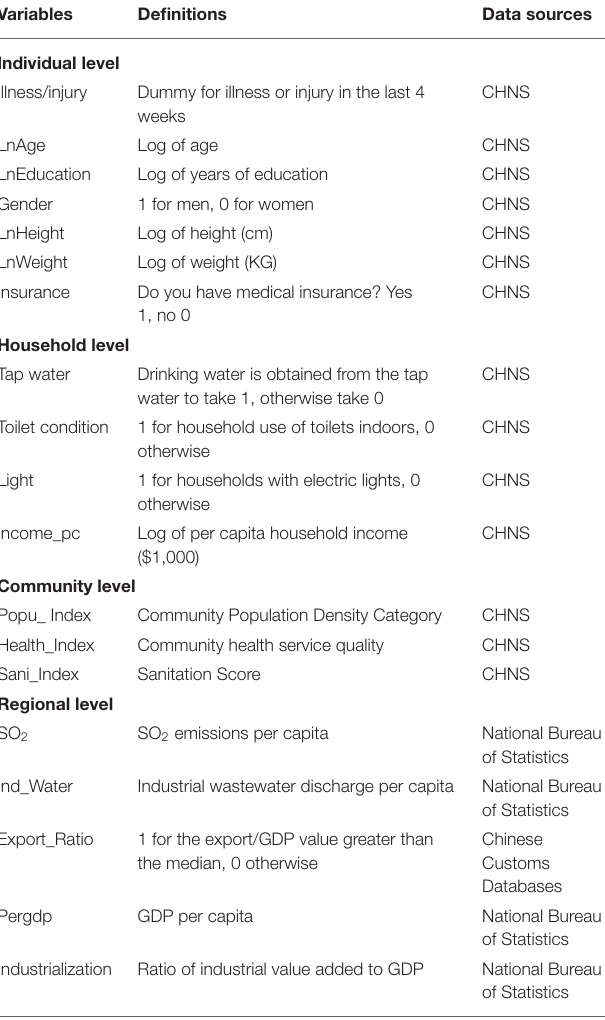
Supplementary Table S4 . To avoid the influence of the